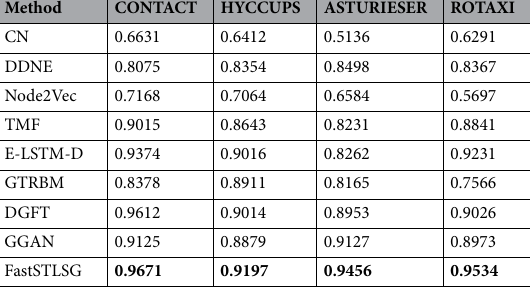
Table 6. Performances on GMAUC for different methods. Significant values are in bold.